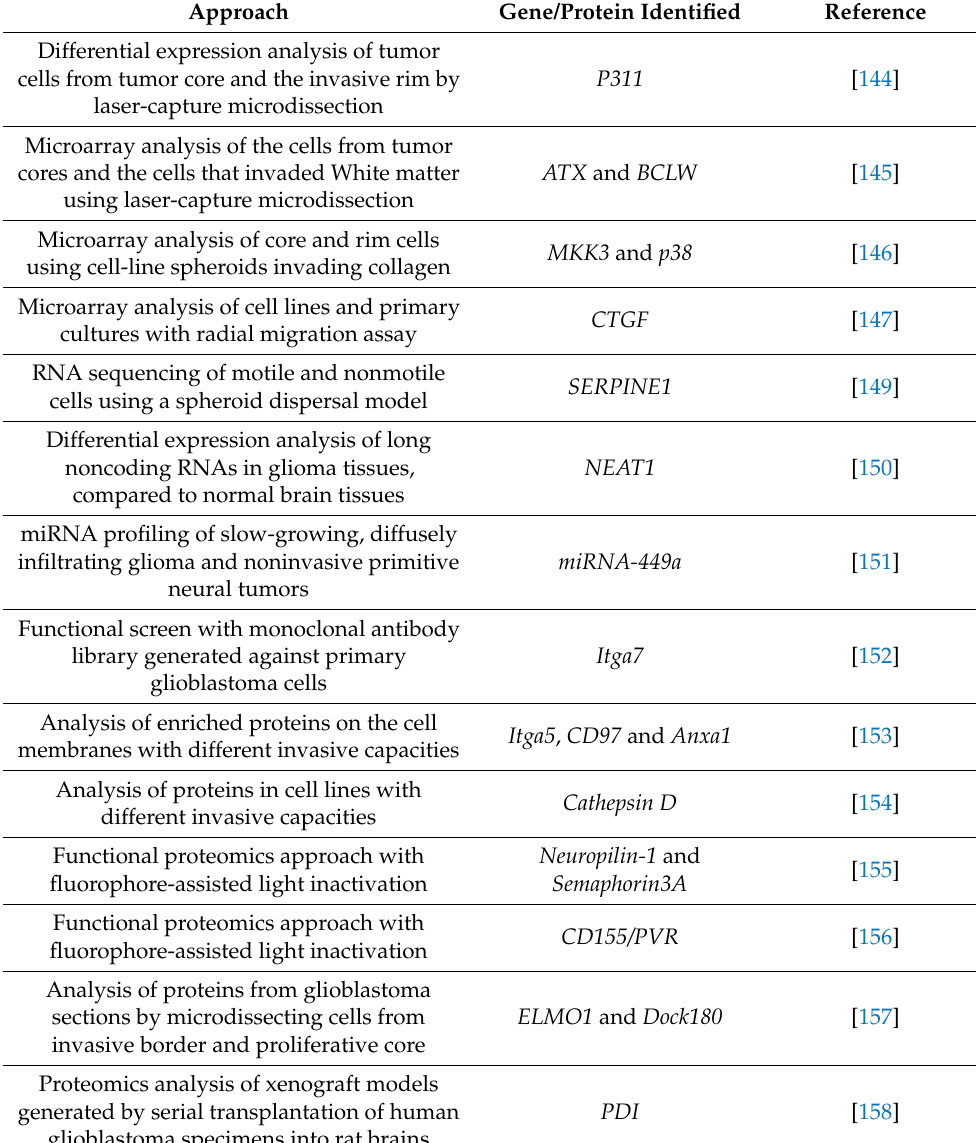
Table 1. Molecules identified as having a role in glioblastoma invasion by unbiased, high-throughput